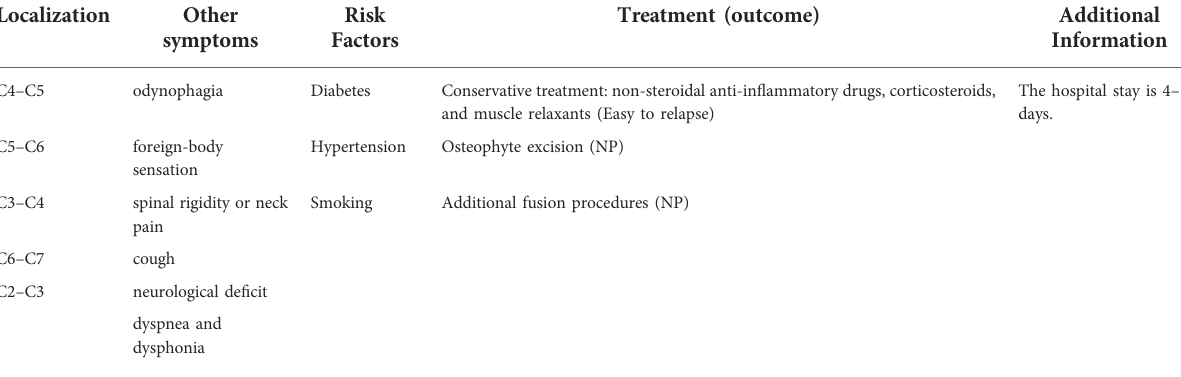
TABLE 2 Summary of clinical characteristics, radiology, treatment, and outcome characteristics.